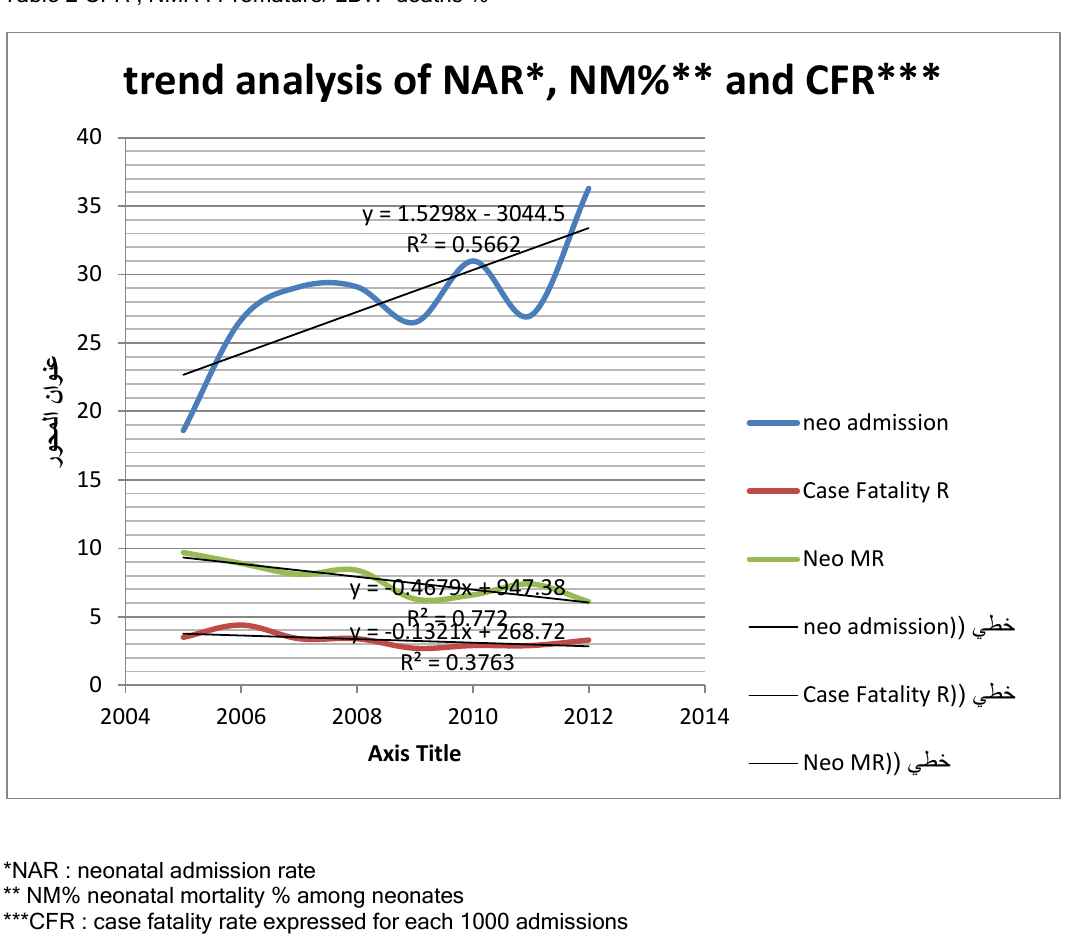
*CFR : case fatality rate for each 1000 pediatrics admissions **NM% : neonatal mortality among neonates admitted to NNU % Table 2 CFR , NMR . Premature/ LBW deaths %